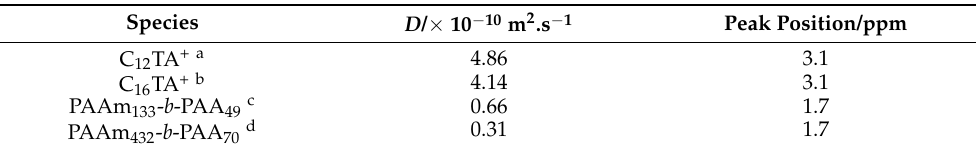
Table 2. Unimer self-diffusion coefficients of surfactant ions and polyions obtained using the indi- cated peaks in 1 H NMR